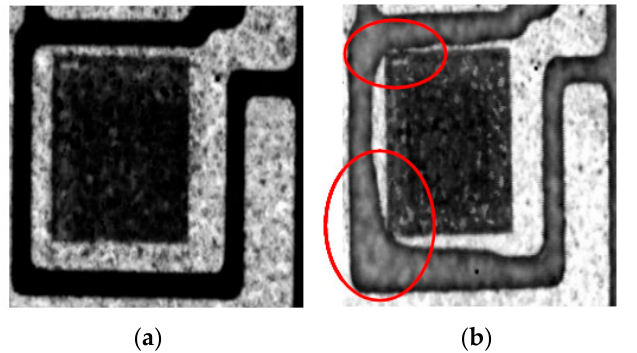
Figure 10. DBC substrate aging, detaching of the upper Cu layer. ( a ) before aging, ( b ) after aging, red circle for detaching area [79].